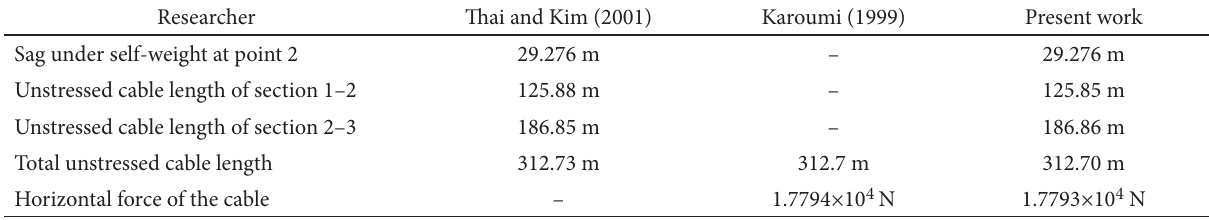
Table 1. Comparison of coordinate, unstressed and horizontal force of isolated cable under self-weight